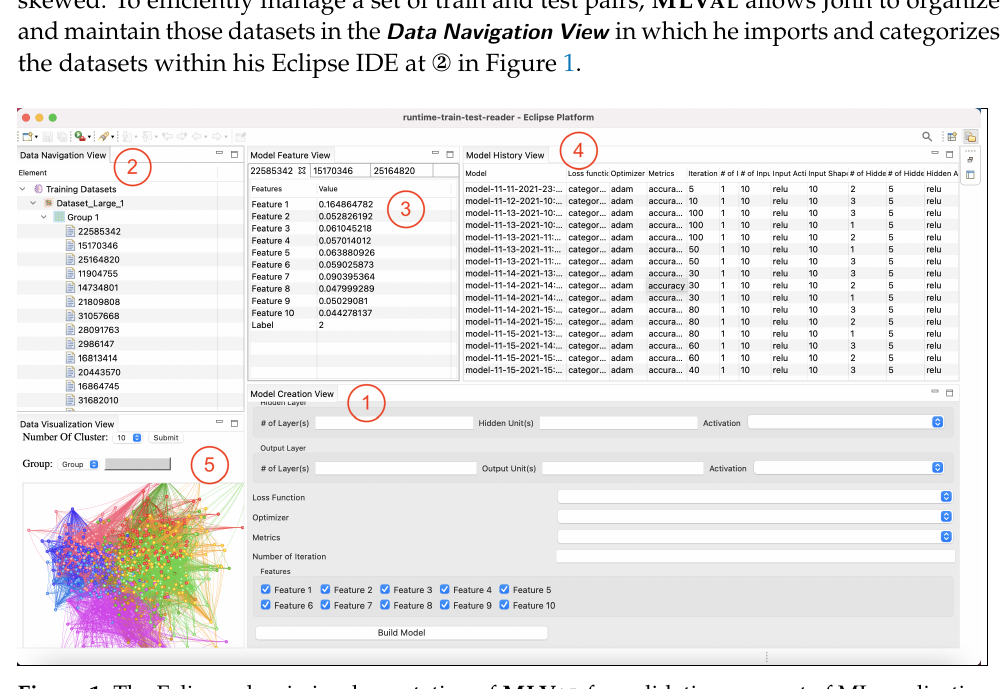
Figure 1. The Eclipse plug-in implementation of MLV AL for validation support of ML applications and